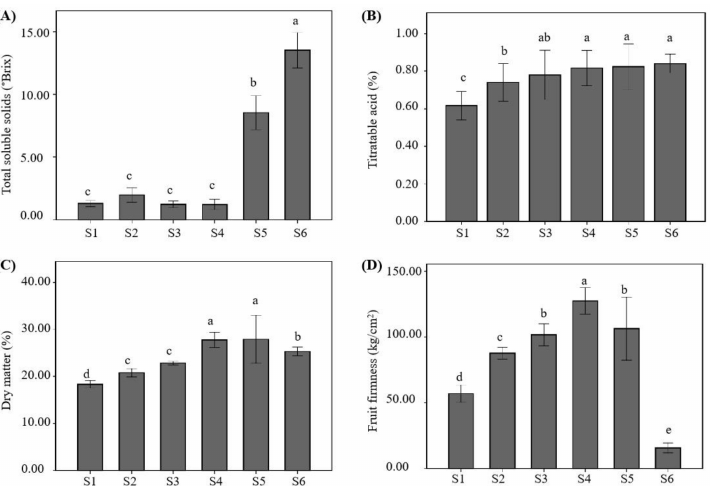
Figure 3. Total soluble solids ( A ), titratable acidity ( B ), dry matter ( C ), and fruit firmness ( D ) in S. obovatifoliola subsp. urophylla fruit at different ripening stages. Means with different letters within the same fruit character indicate statistical differences at the p < 0.05 level using the LSD